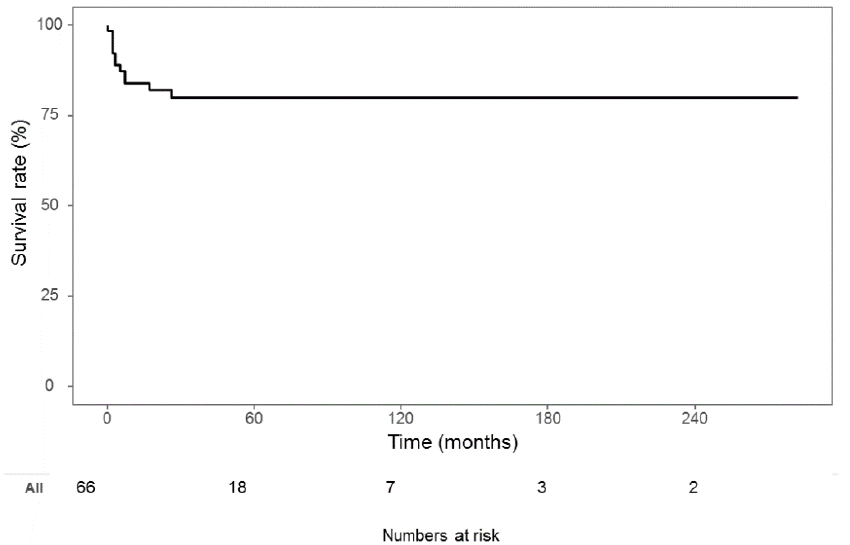
Figure 3. Overall survival was shown in this figure. Overall survival rate was 81.8%, and the median follow-up period was 35 months.